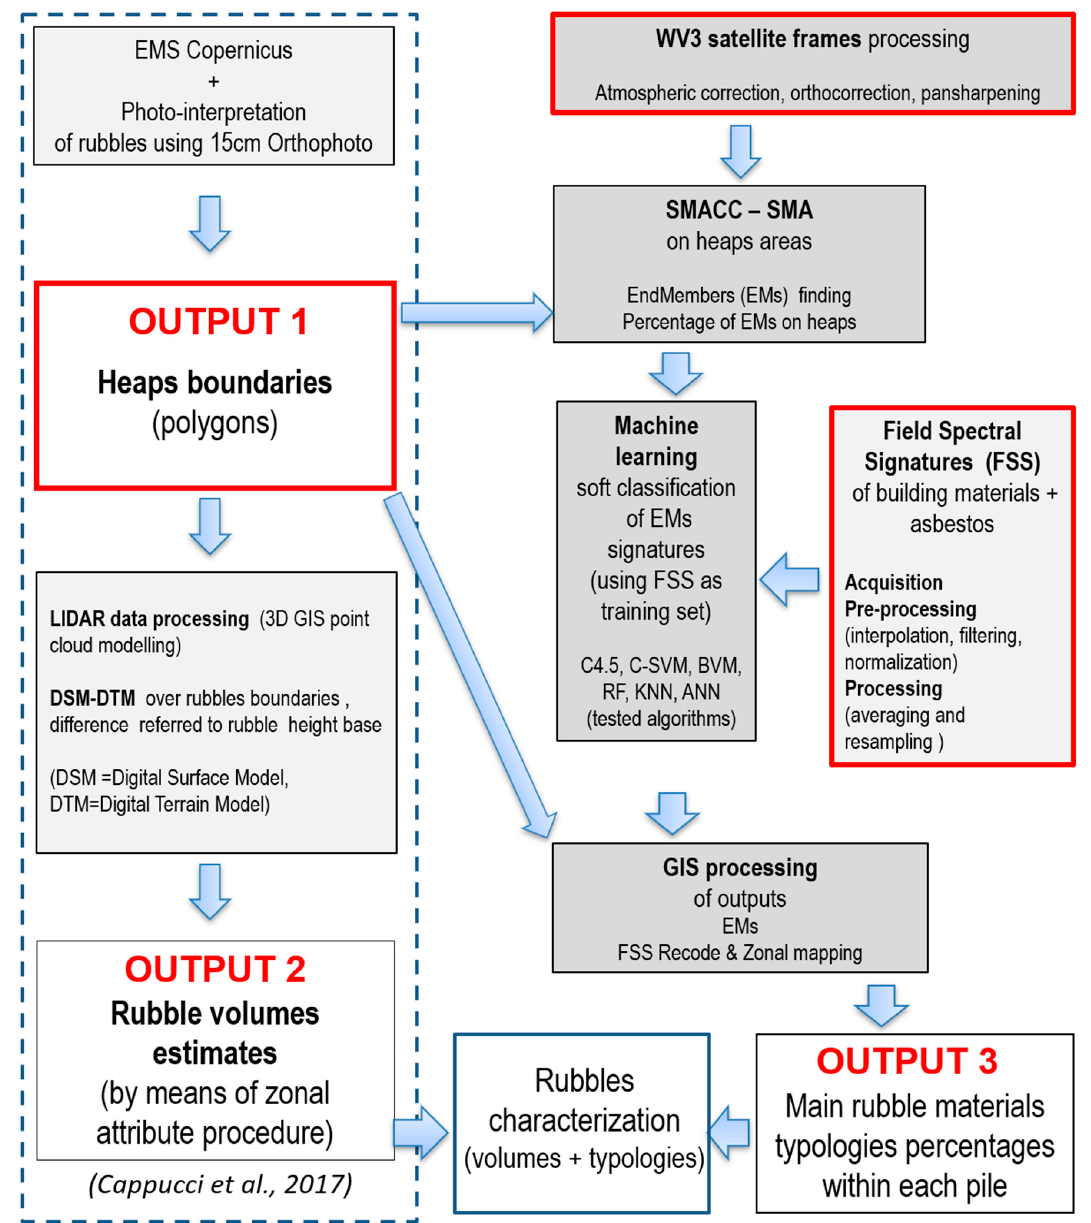
Figure 2. Flow diagram of the implemented procedure. The input data are: (1) LiDAR point cloud data, RGB aerophotos, Copernicus EMS building damaging grade map; (2) WorldView-3 multispectral data; (3) hyperspectral signature library; (4) polygonal cover and related attributes of rubble heaps, from previously developed procedure [1], in input to SMACC and GIS processing. The rough outline of rubble volume estimates procedure (dashed box) has been included here only for completeness.